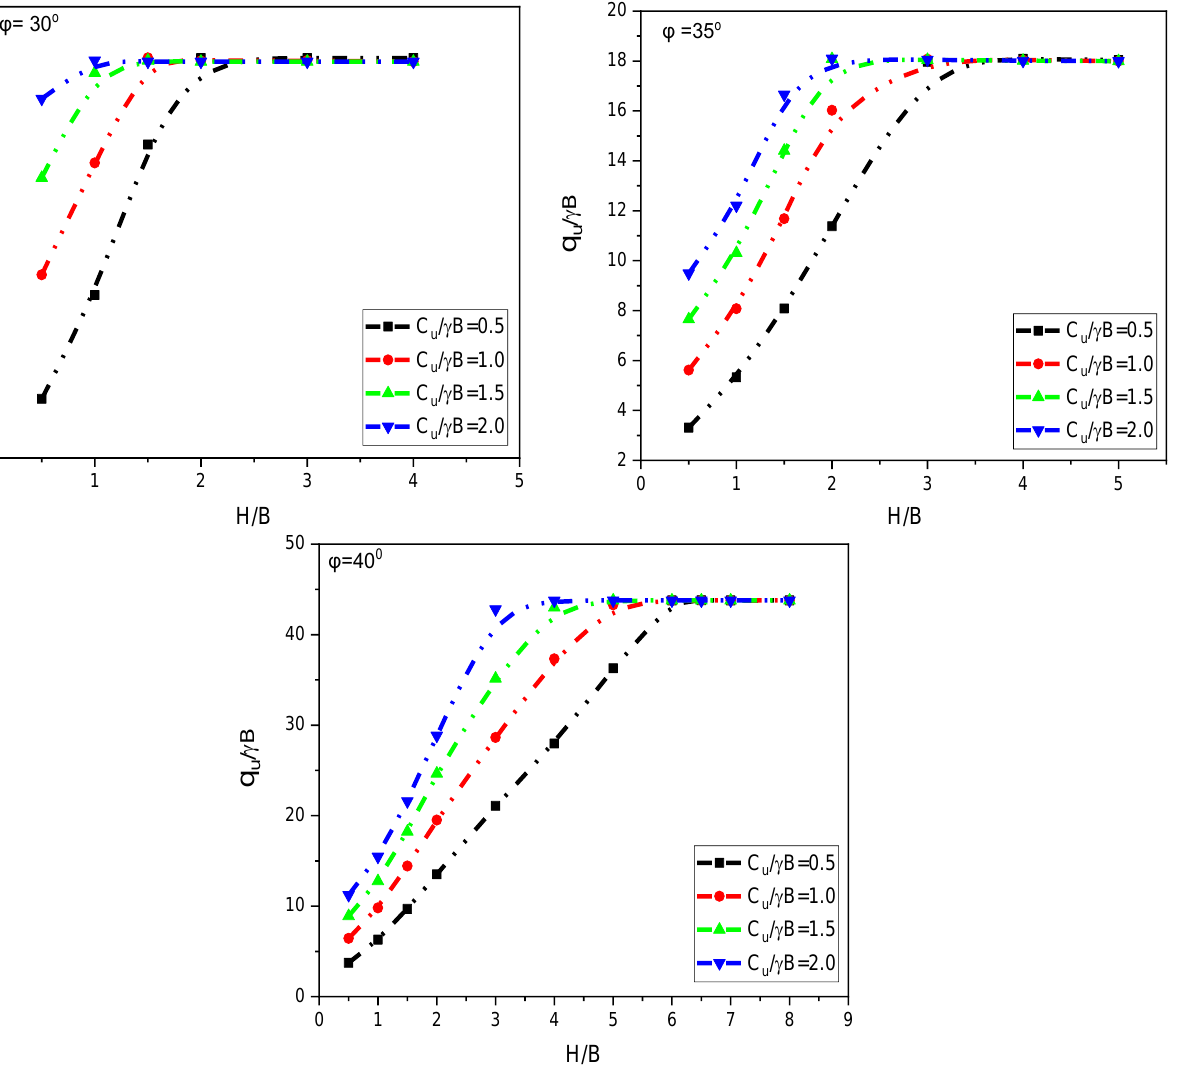
Figure 4. Effect of the clay and sand parameters on the ultimate bearing capacity ratio qu/γB .